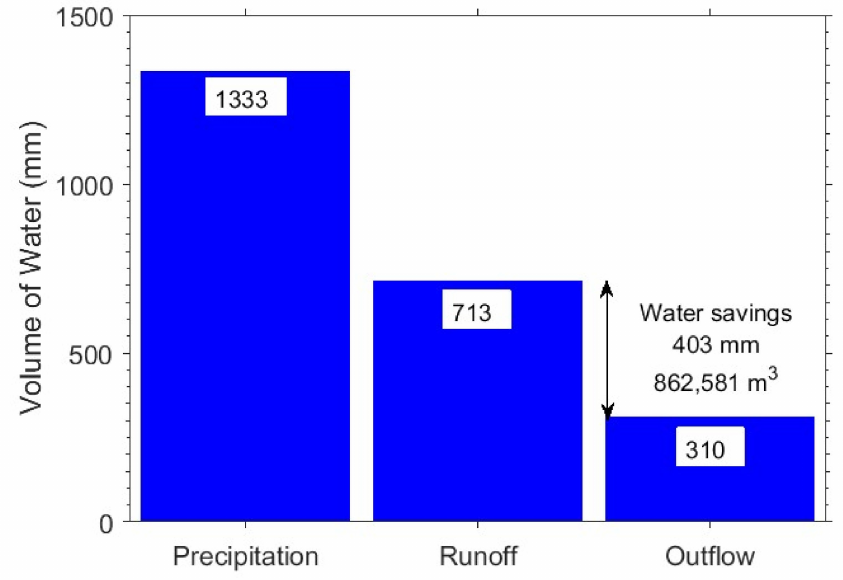
Figure 8. On-farm water storage (OFWS) system water savings potential estimated for